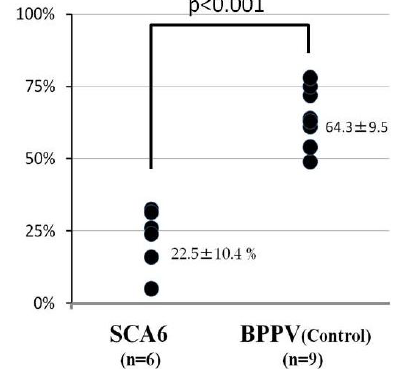
Figure 1. Results of the visual suppression test in SCA6 patients and control subjects. From a dark environment with the subjects’ eyes covered to a light environment with the subjects’ eyes open and fixed on a target, the slow-phase velocity of caloric nystagmus was suppressed in control subjects (64.3%), whereas the suppression was markedly reduced in SCA6 patients (22.5%) (p < 0.001). SCA6: spinocerebellar ataxia; BPPV: benign paroxysmal positional vertigo served as